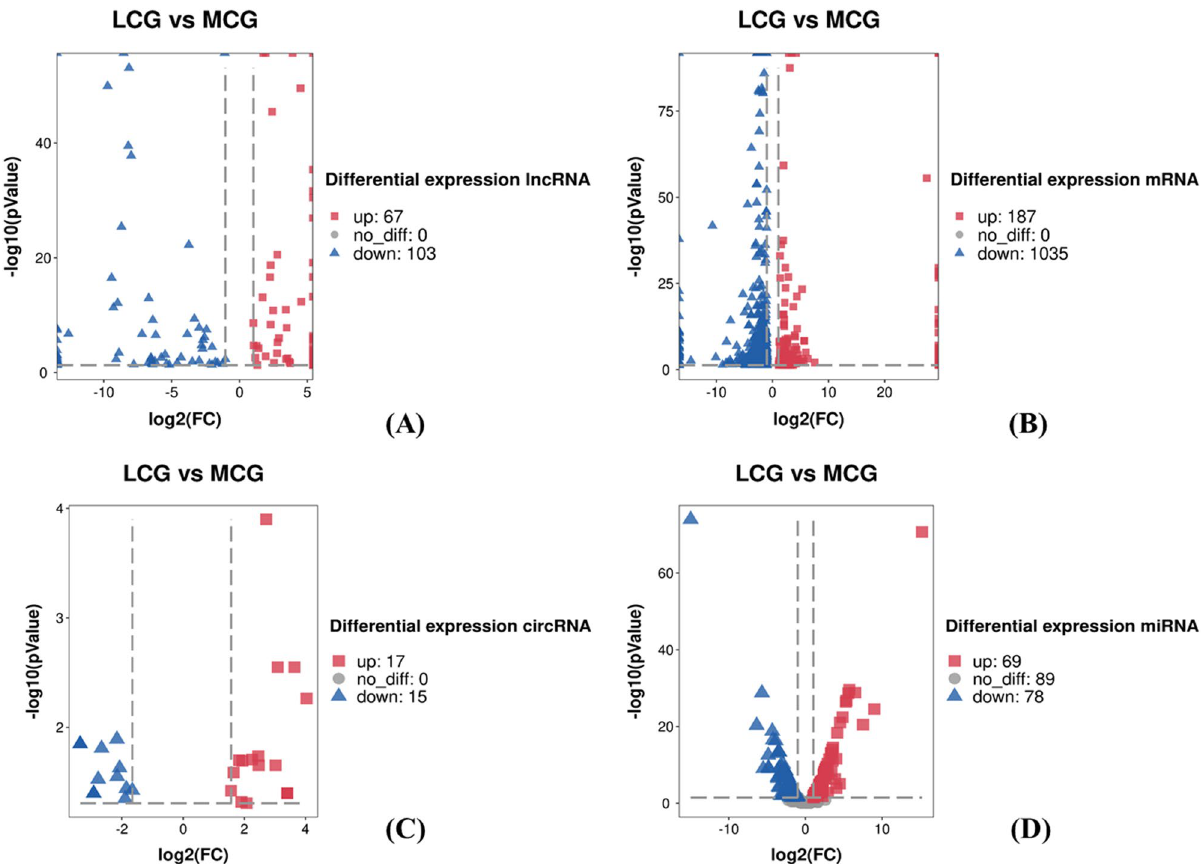
Figure 2. Volcano plot of DElncRNAs, mRNAs, circRNAs and miRNAs between LCG and MCG. ( A ) Volcano plot of DElncRNAs. ( B ) Volcano plot of DEmRNAs. ( C ) Volcano plot of DEcircRNAs. ( D ) Volcano plot of DEmiRNAs.